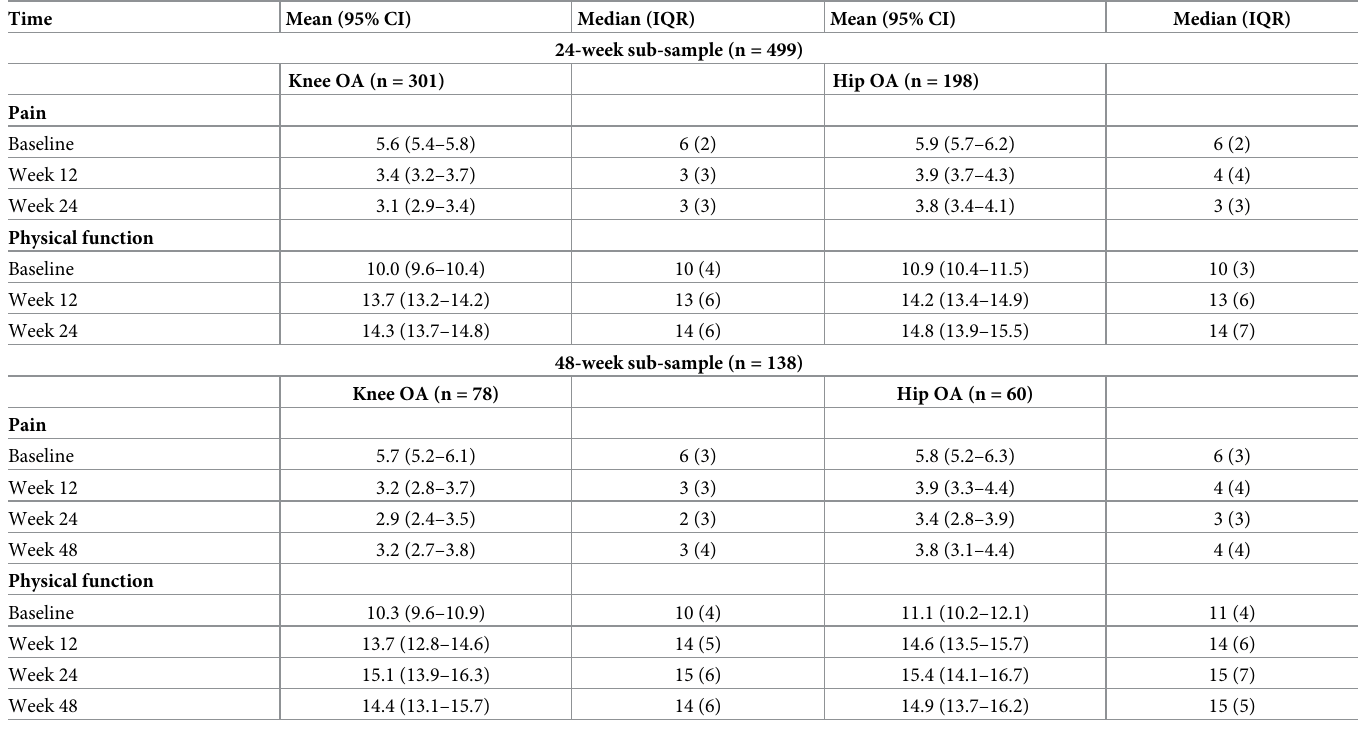
Table 3. Pain and physical function at baseline and